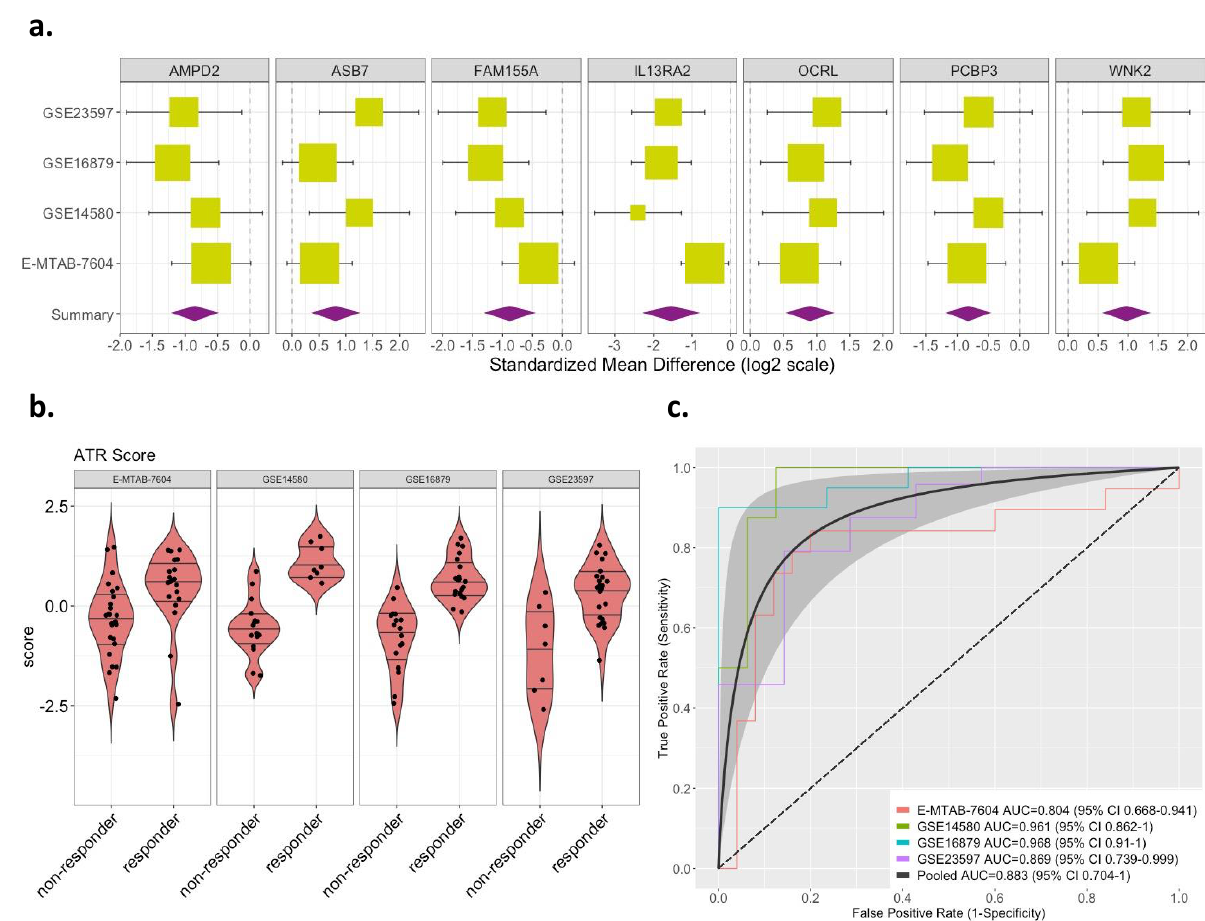
Figure 2. Effect sizes and discriminatory performance of the 7-gene signature. ( a ) Forest plots for random-effects-model estimates of effect size of the 7-gene signature derived from greedy forward search, comparing anti-TNF α responders vs. non-responders (box size is inversely proportional to standard error of effect size; whiskers represent upper and lower confidence intervals). ( b ) Violin plots of ATR scores based on the 7-gene signature in responders vs. non-responders ( p < 0.05). ( c ) ROC curves shown for discriminatory performance of 7-gene signature in discovery datasets obtained with LOSO approach. The dotted line denotes 0.5 AUC line (random guessing). The gray shaded area denotes confidence band around pooled ROC curve (black line).